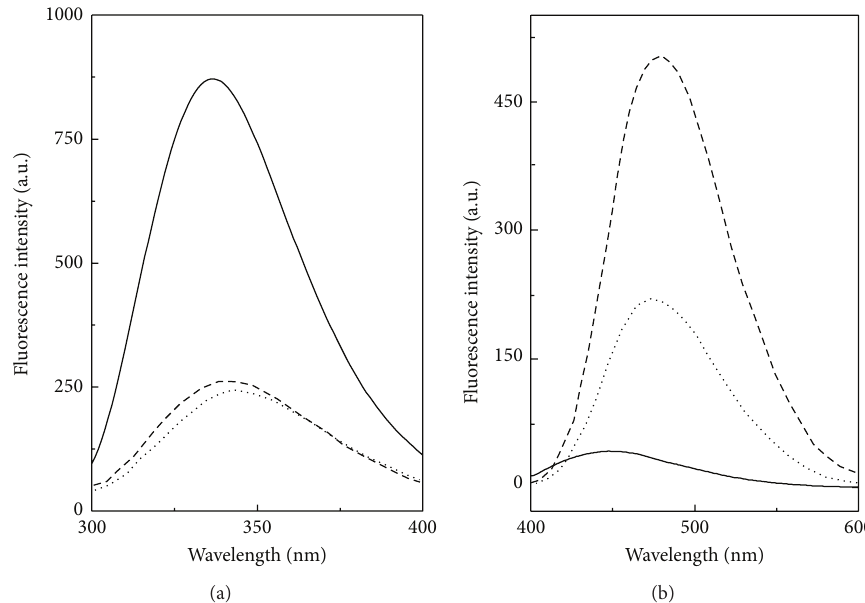
Figure 3: Intrinsic fluorescence (a) and ANS fluorescence (b) spectra of different conformational states of BLA, as obtained at 25 ∘ C using a protein concentration of 0.1 𝜇 M and 0.6 𝜇 M for intrinsic fluorescence and ANS fluorescence measurements, respectively. Native state (—), acid-denatured state ( ⋅ ⋅ ⋅ ), and HFIP-induced state (---).